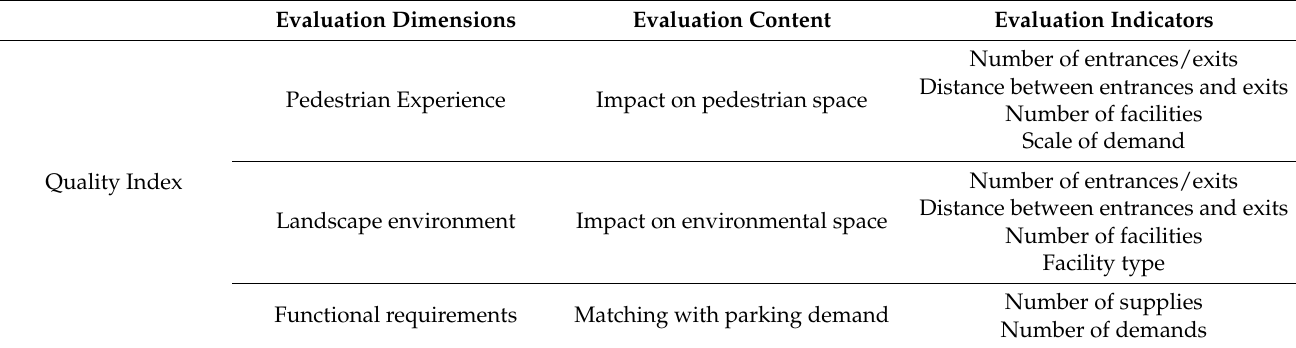
Table 2. Parking Facility Quality Index Evaluation Index System.